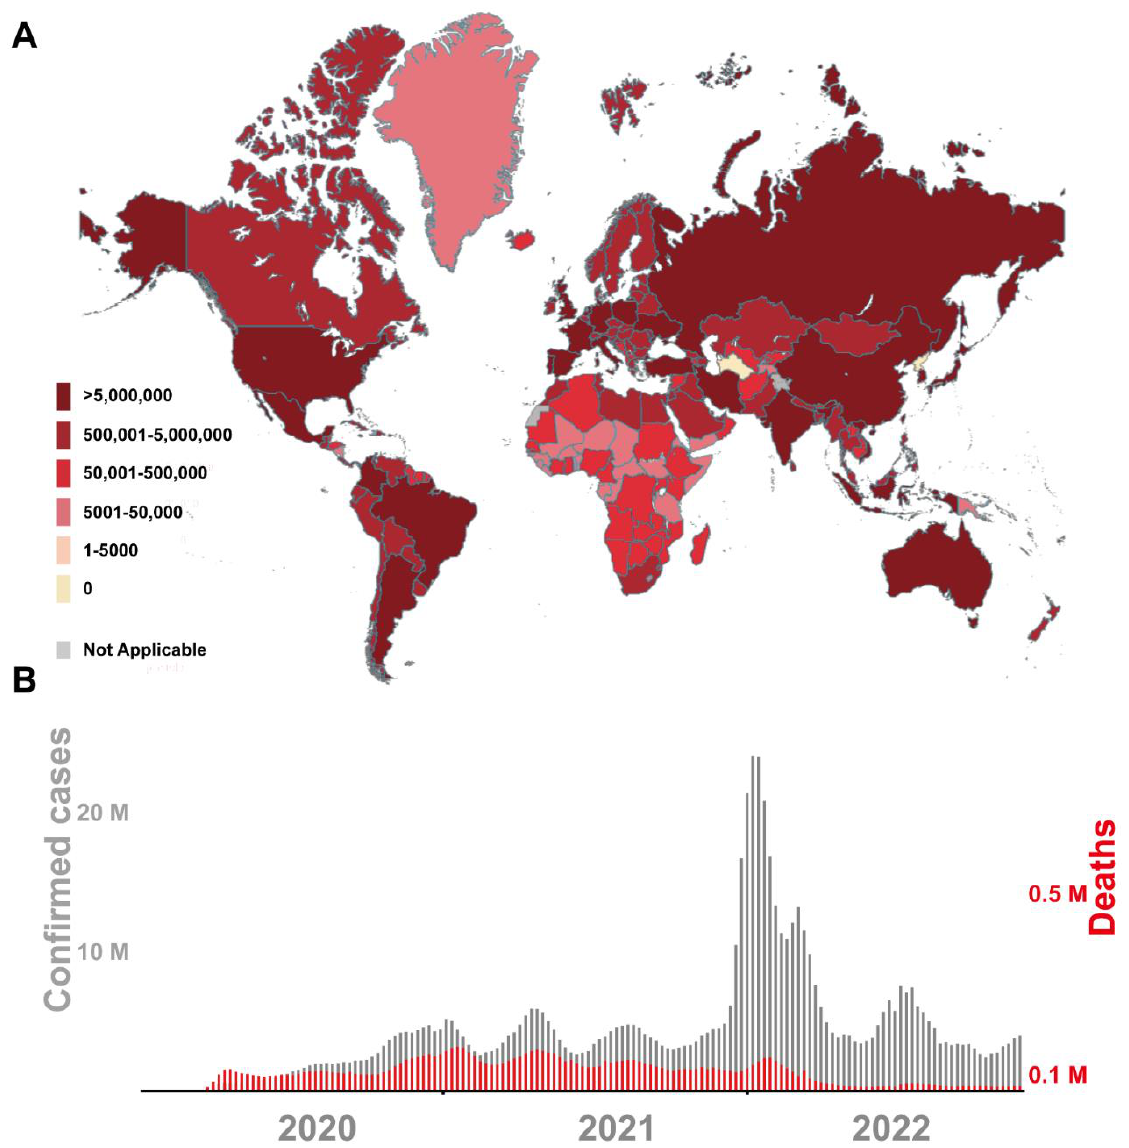
Figure 1. Current global SARS-CoV-2 epidemic situation map ( A ) and number of confirmed cases and deaths ( B ). The figure was obtained on the official website of the World Health Organization